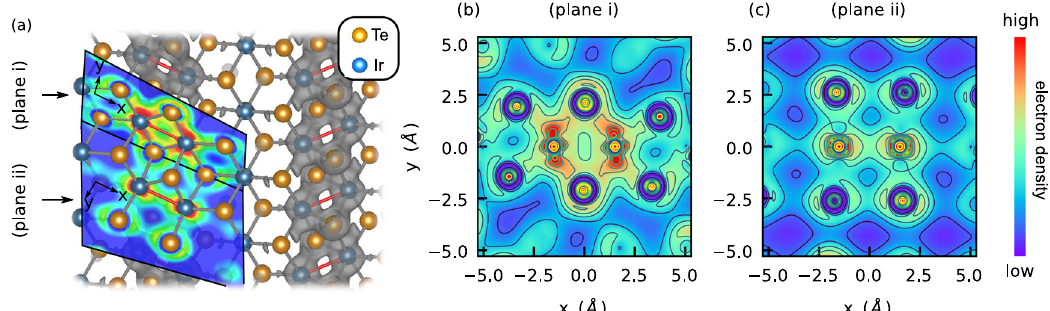
Fig. 6 Charge-density distribution of the bonding dimer-states in the 1/6-phase. The shown electron density corresponds to the Kohn-Sham states within an energy window of − 7 to − 6.5 eV for a density functional theory calculation which uses the experimental crystal structure at 6.5 GPa. a Cuts through the charge density parallel to two different planes (i, ii) placed into the lattice structure. The short Ir-Ir distances within a dimer are indicated by red lines. Gray-shaded ring-like structures indicate the charge distribution of the bonding states of the dimers (contour level of the iso surface: 6 × 10 − 4 e/ Å − 3 ). b , c Contour plots of the charge densities of these covalent bonds for plane i and plane ii. The position of the planes is indicated in ( a ). The color bar quanti fi es the electron